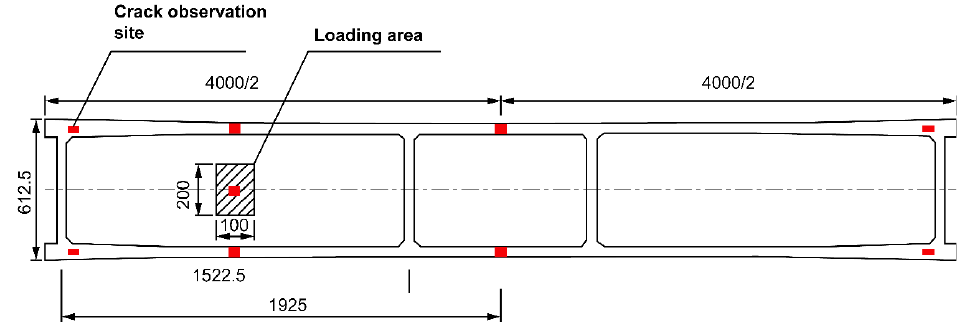
Figure 7. Loading position and displacement gauge field layout (mm).